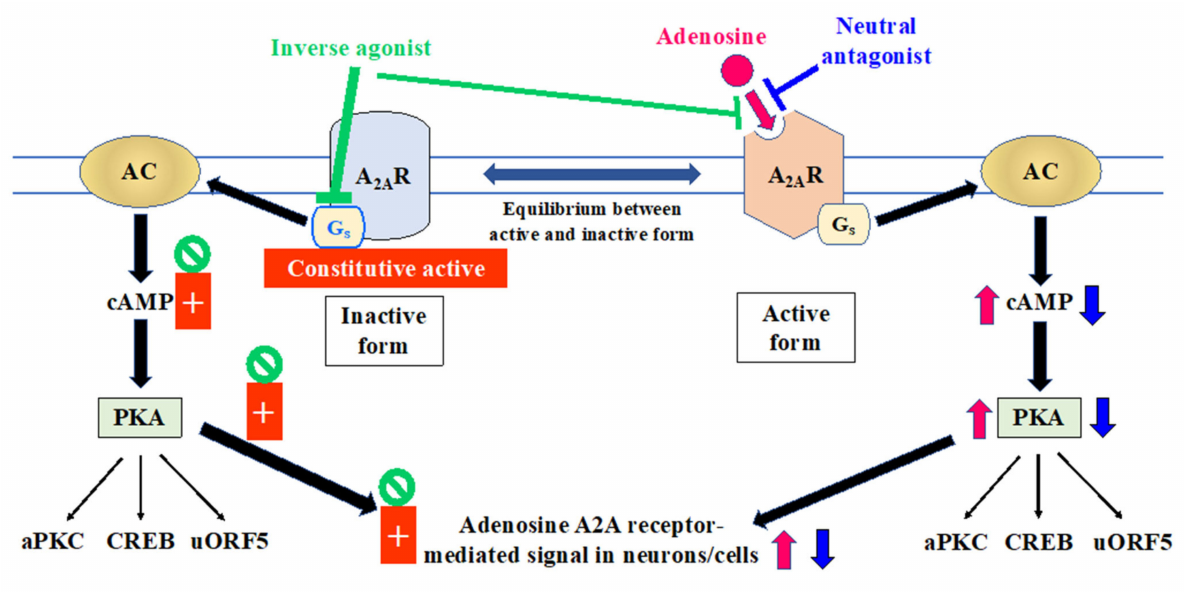
Figure 2. Two-state model of adenosine A 2A receptor and its major intracellular signal transduction. Endogenous ligand adenosine binds with higher affinity to the active form of Gs- coupled A 2A receptors, and activates cAMP/PKA pathway via AC. This adenosine-induced cAMP accumulation activates PKA, following activation of multiple downstream targets, such as aPKC, CREB, and uORF5. Neutral antagonists bind to active forms of the